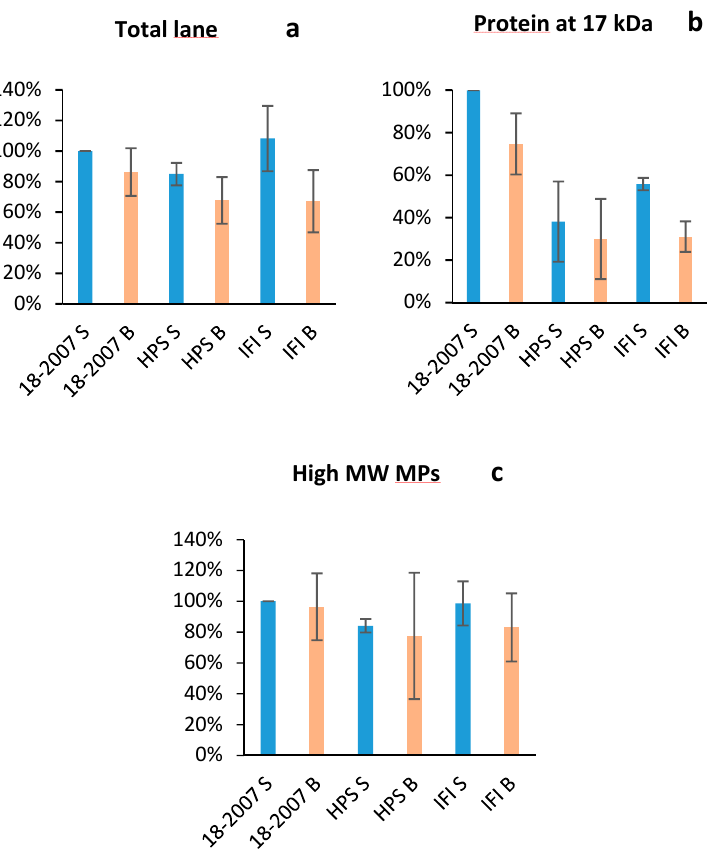
Figure 6. Protein contents in the wines after SDS-PAGE and densitometric integration. PAS staining. ( a ) Total proteins; ( b ) glycoprotein at 17 kDa; ( c ) high molecular weight MPs.